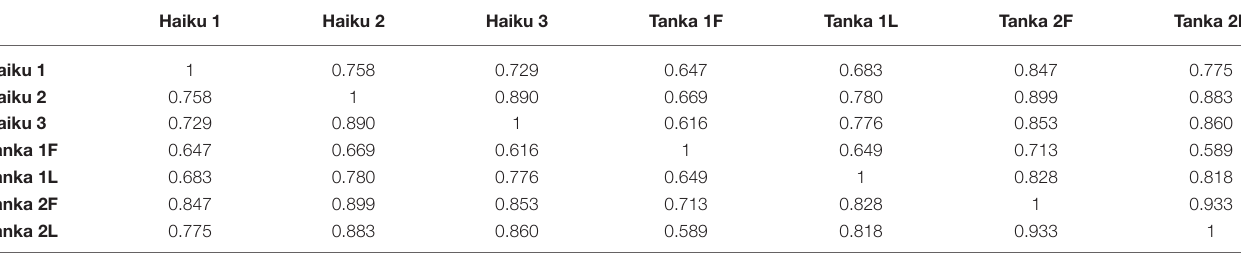
TABLE 11 | Peason’s correlation coefficient between frequency distributions of two poetries. Haiku 1